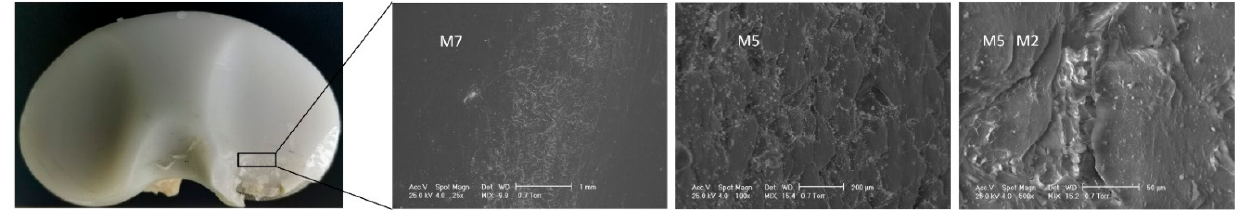
Figure 7. Stereomicroscopy images obtained in the case of IT4 sample.